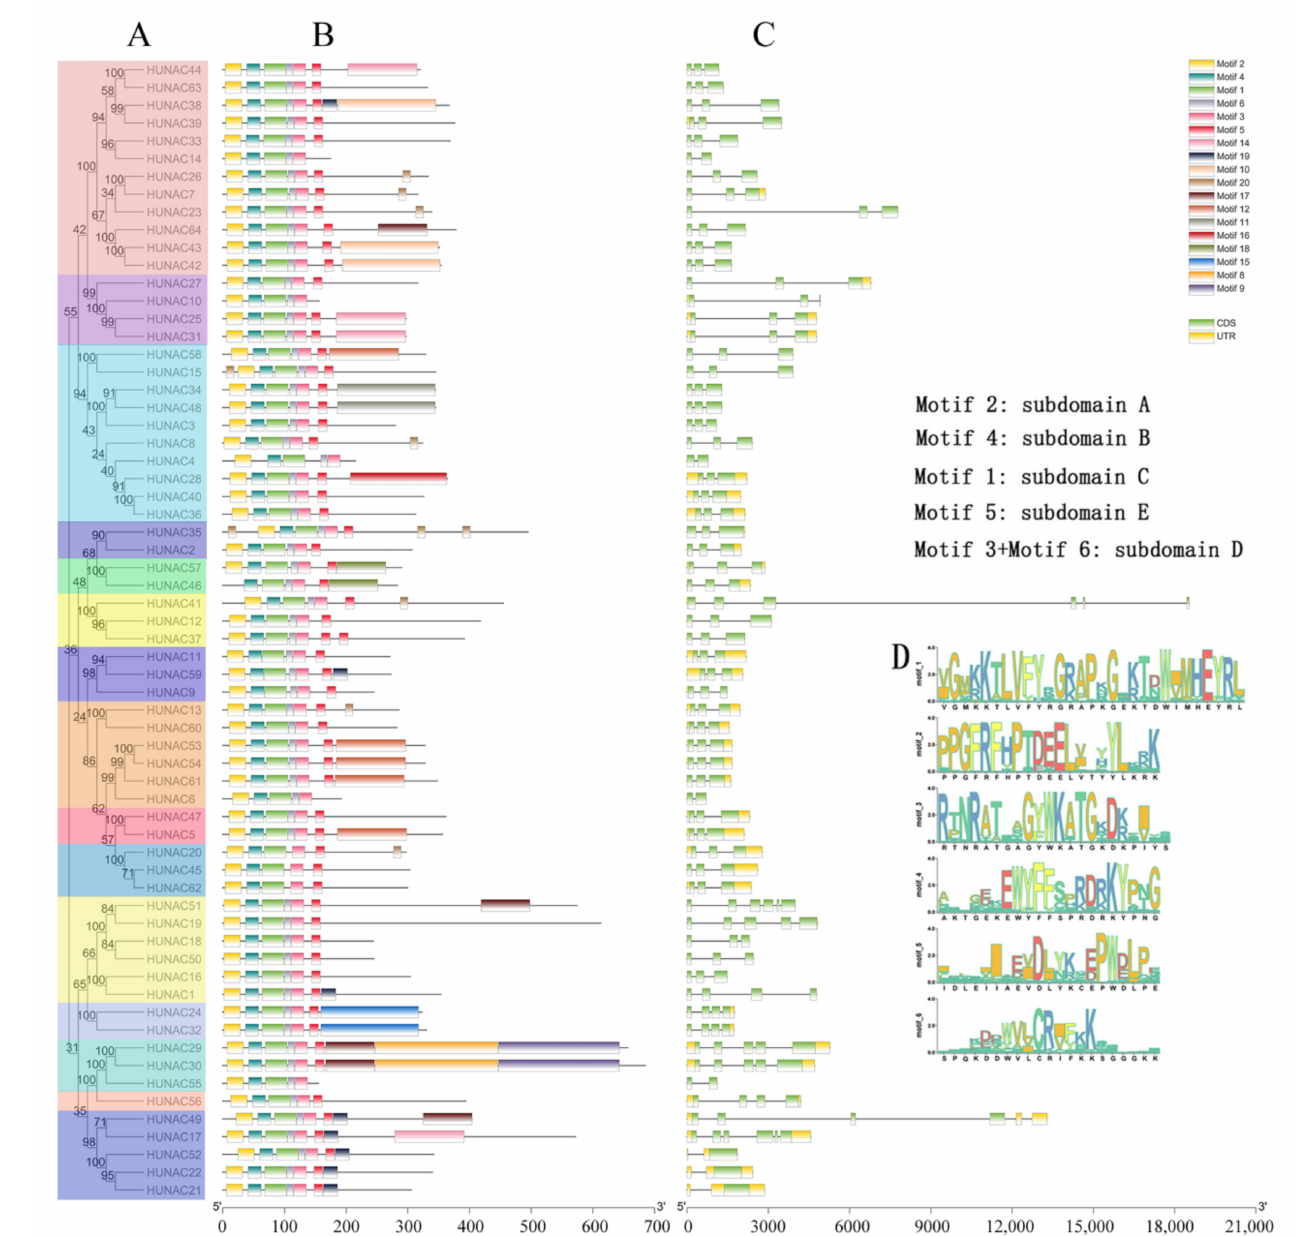
Figure 2. Phylogenetic relationship, gene structure, and conserved motif analyses of 64 HuNAC genes. ( A ) Phylogenetic tree. The phylogenetic tree was constructed using the neighbor-joining method through MEGAX software. The bootstrap analysis was conducted with 1000 replicates. ( B ) protein motif. Schematic diagrams of possible conserved motifs in HuNAC proteins. MEME tool was used to find out the conserved motifs; ( C ) gene structure. The green bars indicate the exons, and the black lines indicate the introns. Yellow bars indicate the UTR region; ( D ) the sequences of key motifs (motif 1, motif 2, motif 3, motif 4, motif 5 and motif